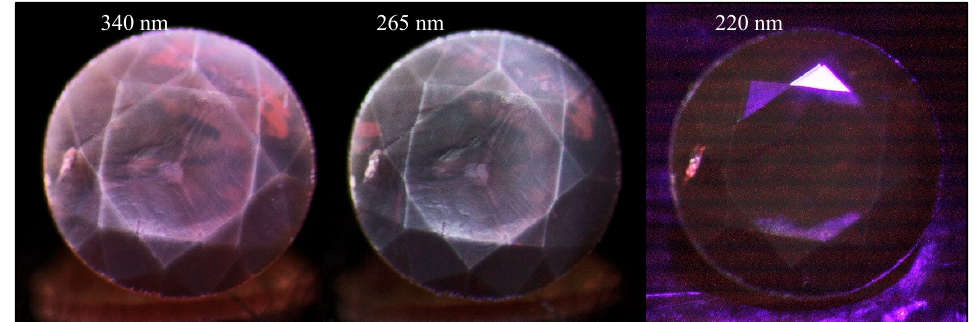
Figure 28. A deep orange-brown hydrogen-rich type IbXY diamond (sample TH 2.327) under three different UV excitations of the DFI system. The fluorescence distribution with the “Mercedes star” in the core (three-fold symmetry) is indicative of the mixed cuboid octahedral growth of the diamond. The “Mercedes star” is representative of the octahedral growth sector. The PL at 340 nm is caused by a very broad PL band centered at about 640 nm and that ranges from 400 to 800 nm.